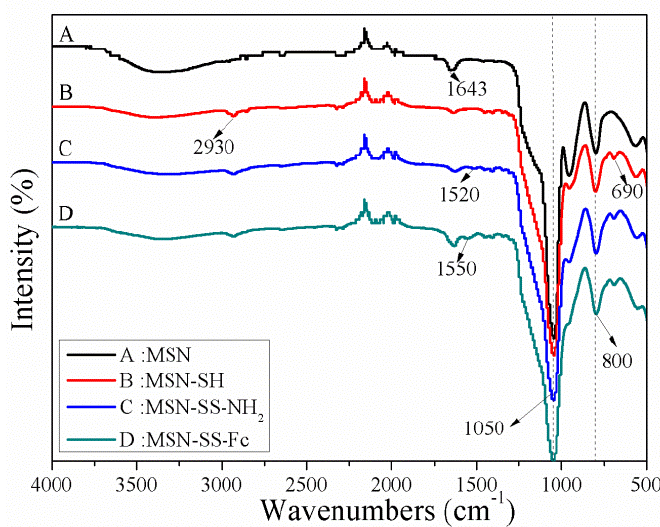
Figure 1. FTIR spectra of MSNs ( A ), MSN-SH ( B ), MSN-SS-NH 2 ( C ), and MSN-SS-Fc ( D ).